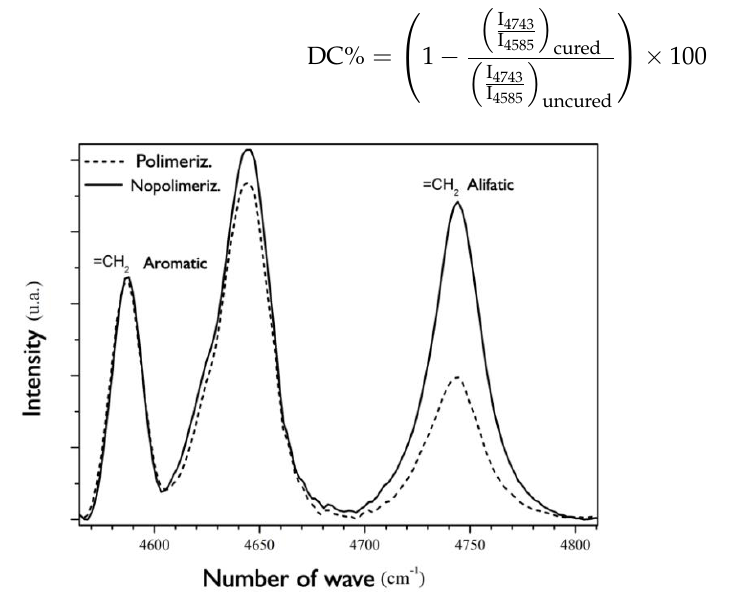
Figure 3. Absorption spectrum of resin − based composites before (SPol) and after (Pol) polymerization.